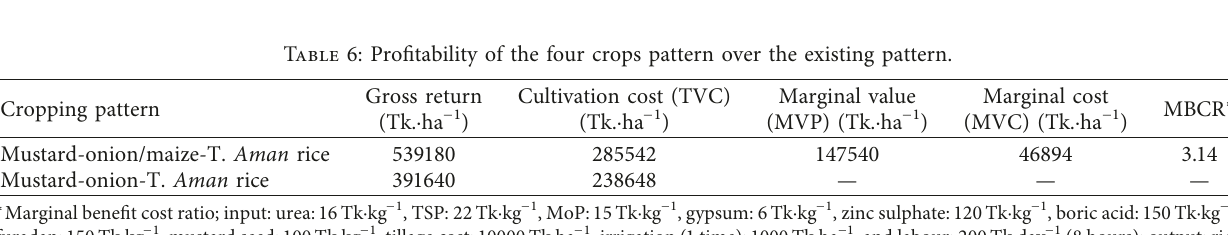
Table 5: Field crop duration, production efficiency, and land use efficiency as influenced by cropping patterns. Cropping pattern